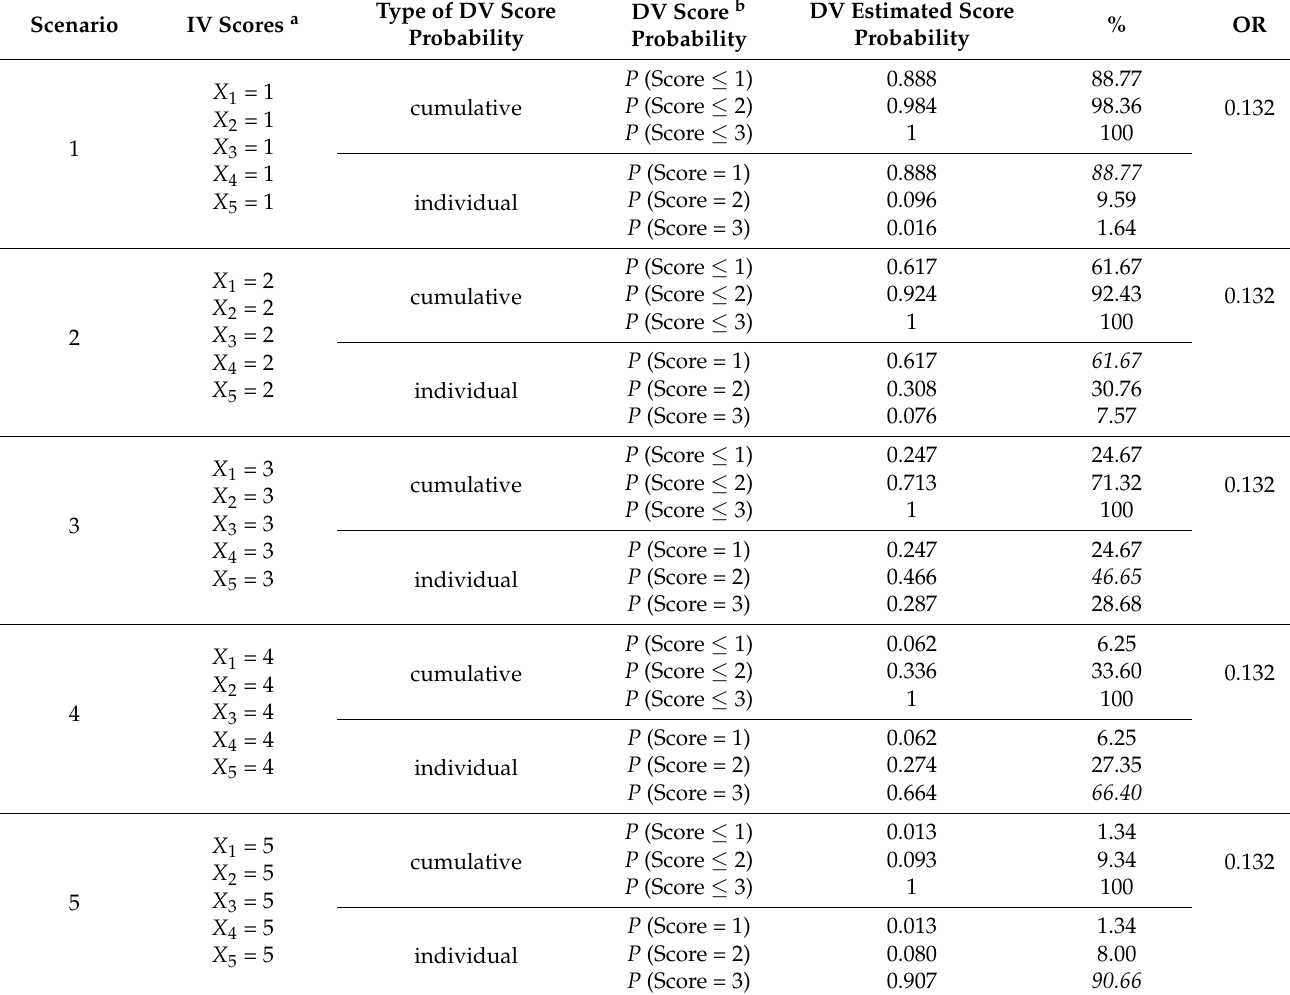
Table 5. Sensitivity analysis and scenario applications of the developed prediction